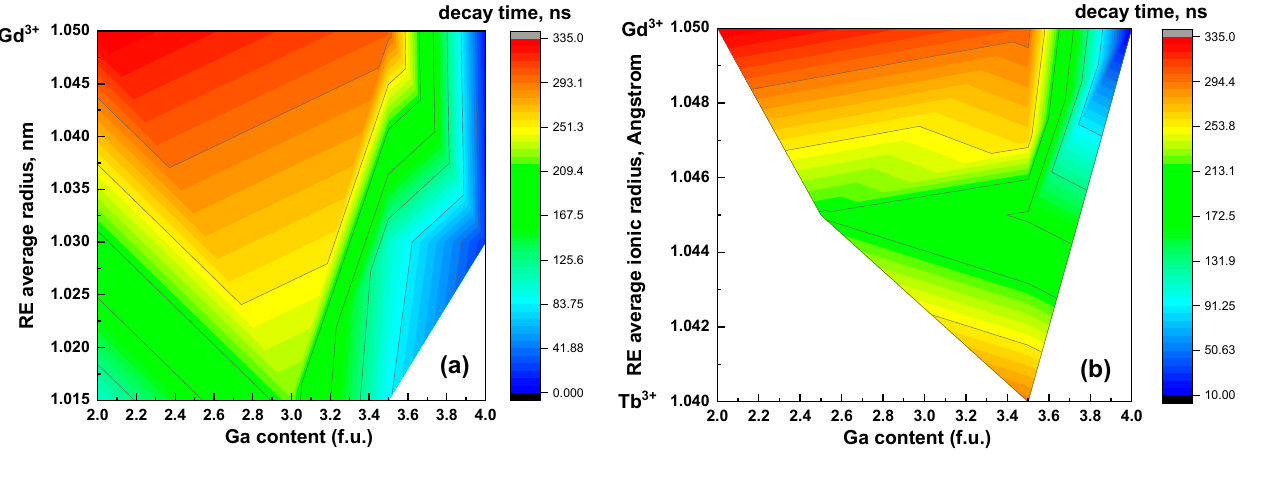
Figure 5. Scintillation decay time (1/e) in (Gd,Lu) 3 (Al,Ga) 5 O 12 :Ce ( a ) (Gd,Tb) 3 (Al,Ga) 5 O 12 :Ce ( b ) films in dependence on average ionic radius of the rare earth ion and Ga content in the films under α -particle excitation.